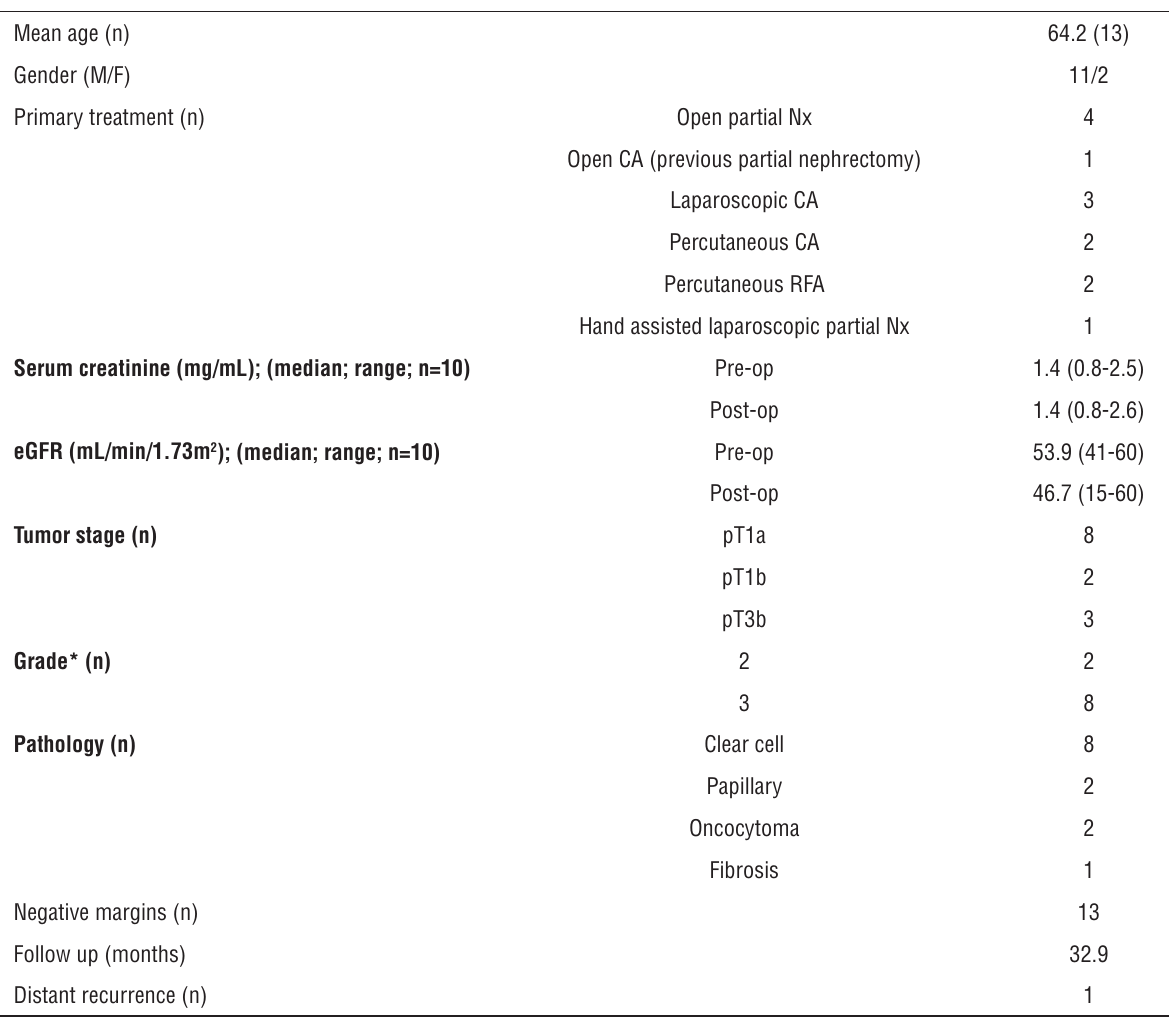
Table 1 - Summary of patient demographics, clinical data, surgical treatments and pathology.